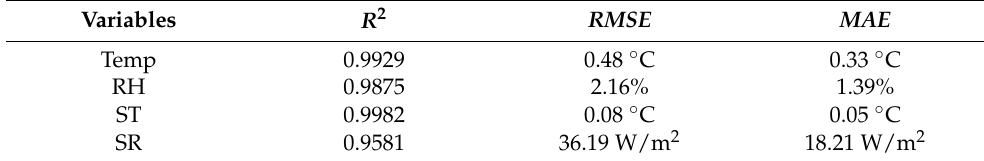
Figure 4. The solar greenhouse internal environmental factors prediction results. ( a ) Temp, ( b ) RH, ( c ) ST, ( d ) SR. Table 4. Error evaluation indicators of environmental factors prediction